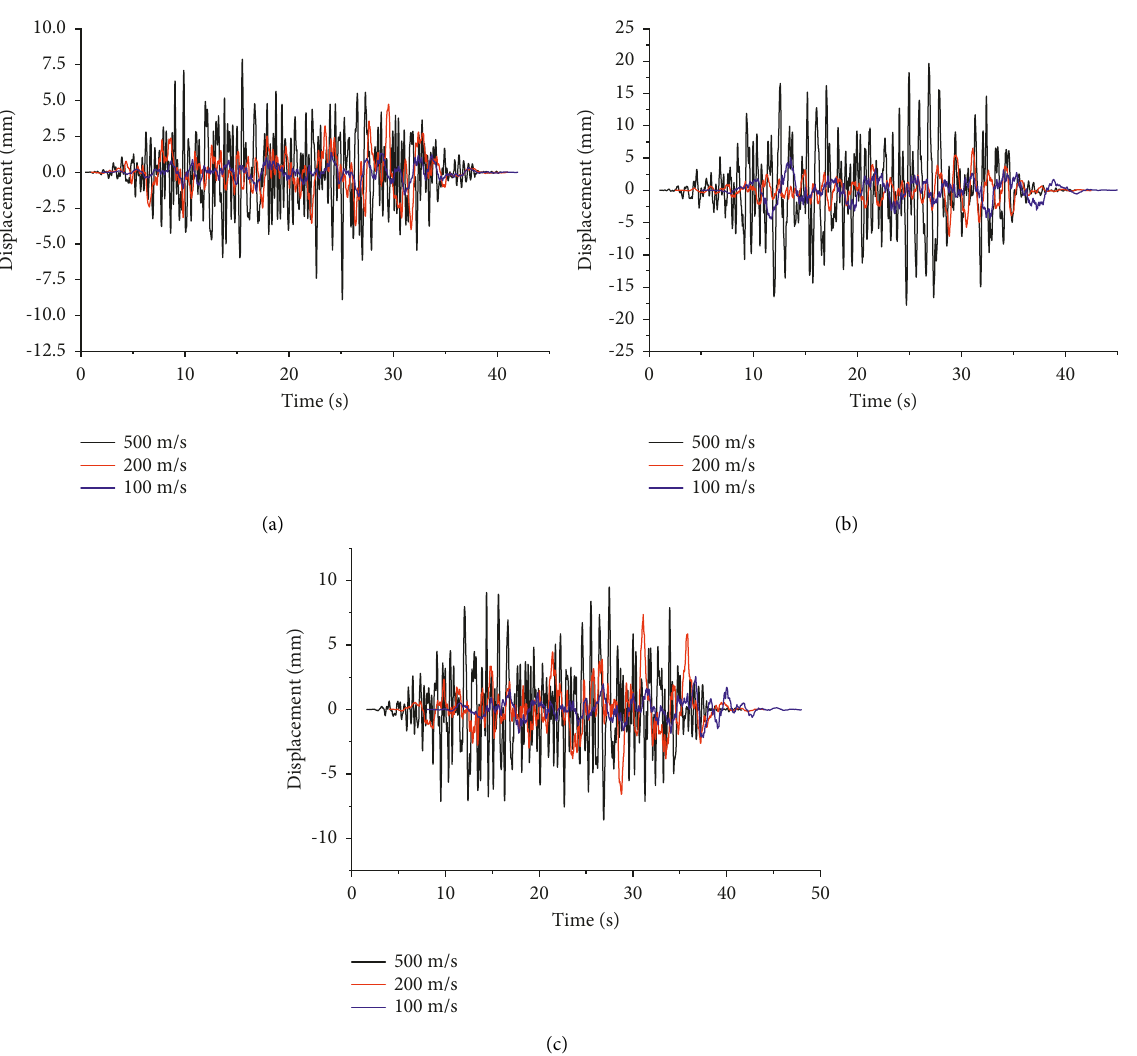
Figure 7: Longitudinal vibration displacement time curve of the pipeline under different wave velocity conditions. (a) Displacement time course curve at 200m (normal). (b) Displacement time course curve at 500m (vacant). (c) Displacement time course curve at 800m (polymer grouting